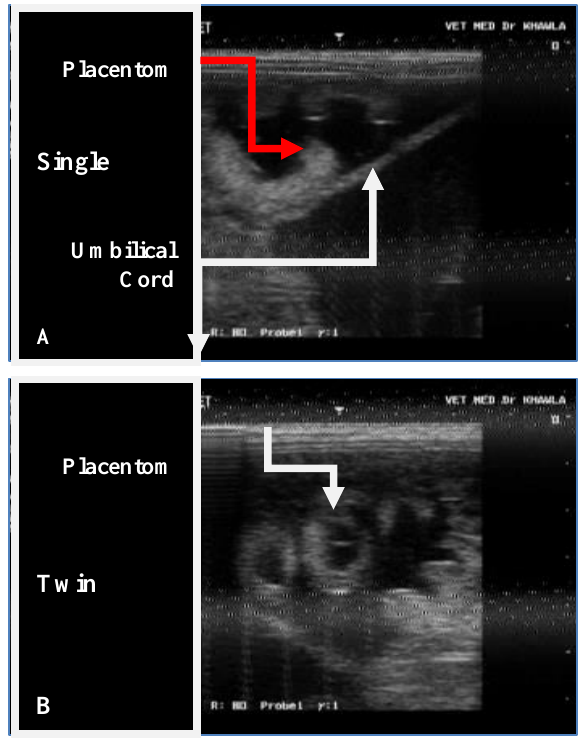
Figure, 3: Placentom size at days 50 of pregnancy in Shami goats . (Advance stage).